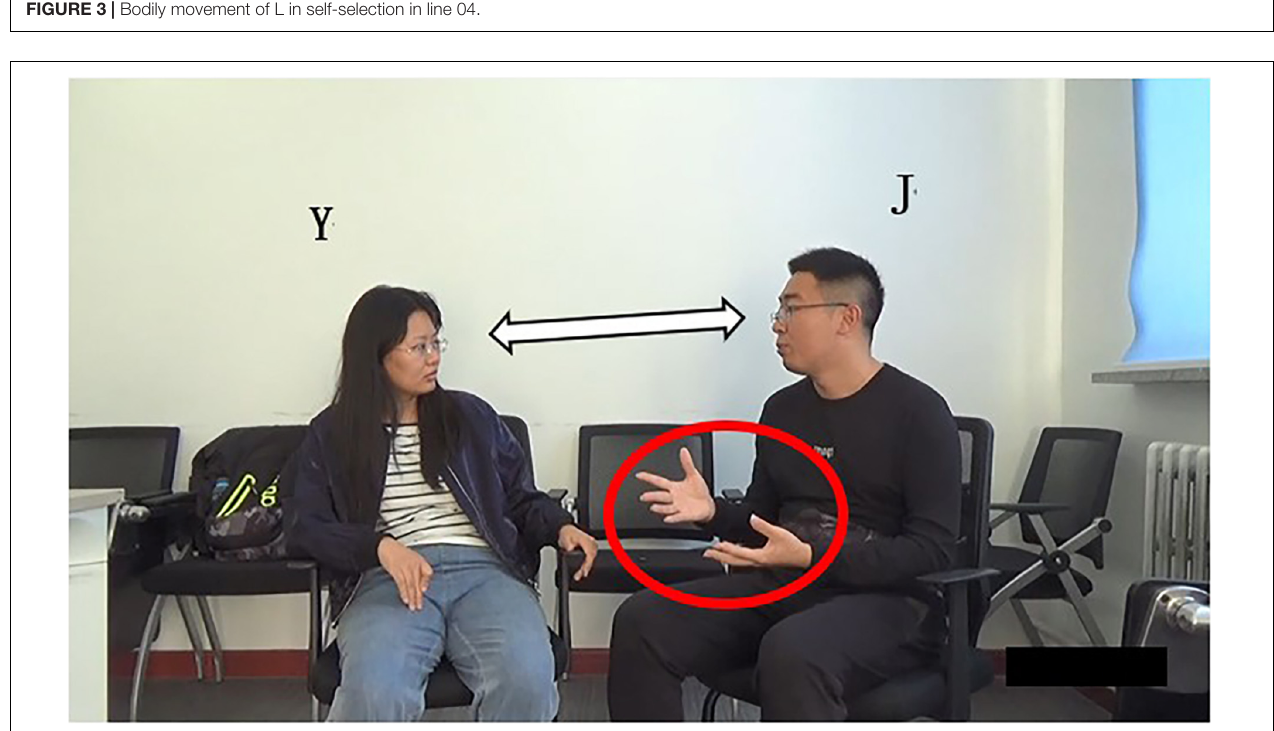
FIGURE 3 | Bodily movement of L in self-selection in line 04.